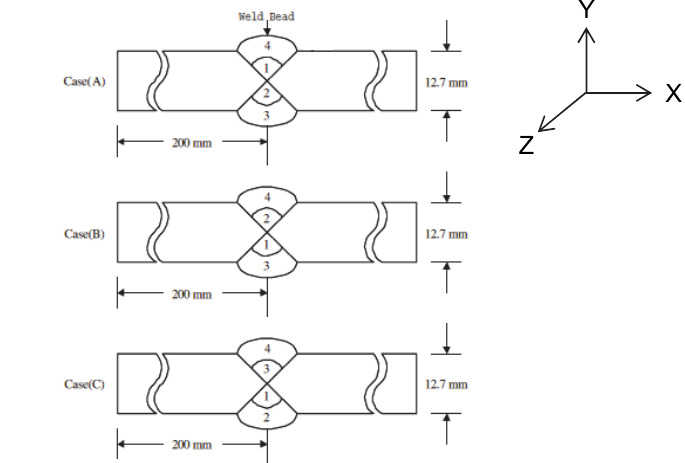
Figure 5: Different cases of multi-pass butt welding sequence [11].